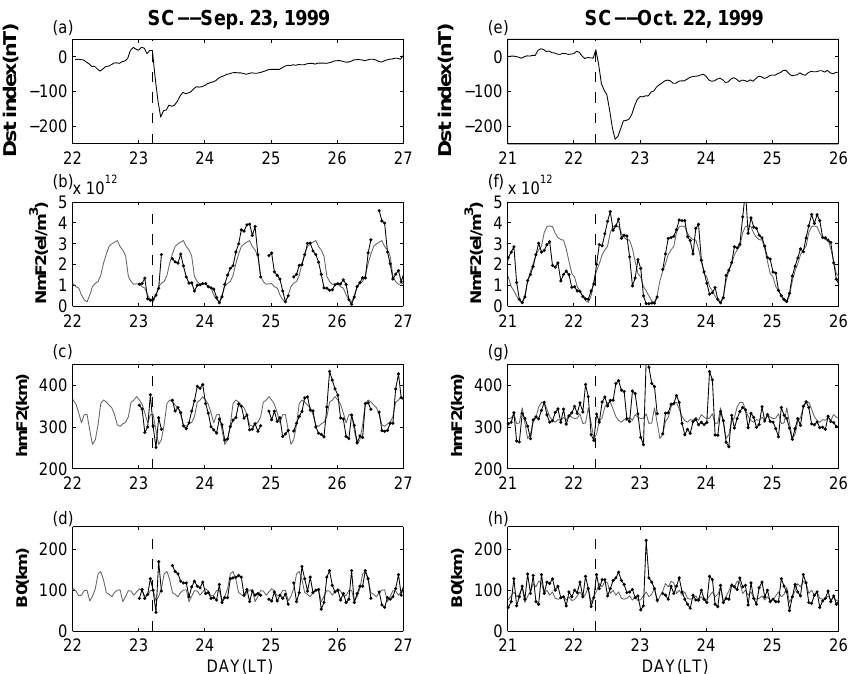
Fig. 4. Variations in Dst, Nm F2, hm F2, and B0 parameters during a geomagnetic storm period on 23 September and 22 October 1999, respectively. The dotted and gray solid lines denote the observed and monthly median values, respectively. The vertical dash line denotes the SSC onset.